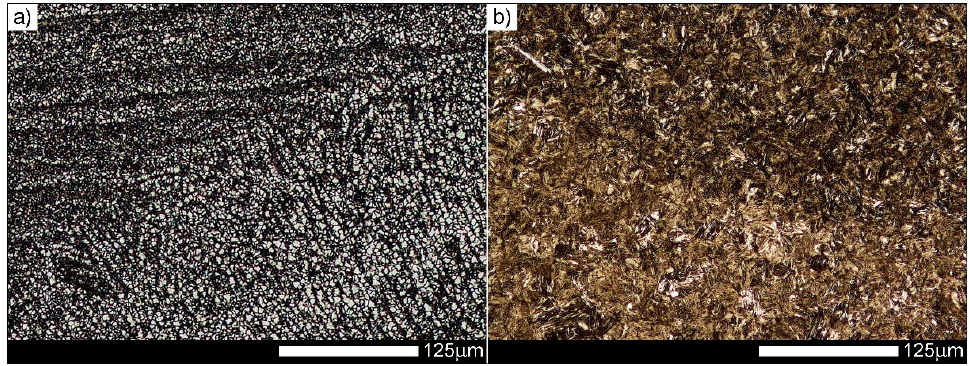
Figure 10. Microstructures of the Hardox 600 joint within weld metal zone—WM3 in Figure 3: ( a ) after welding; and ( b ) after welding and heat treatment. F—ferrite, M—martensite. Light microscopy, etched with 2% HNO 3 .